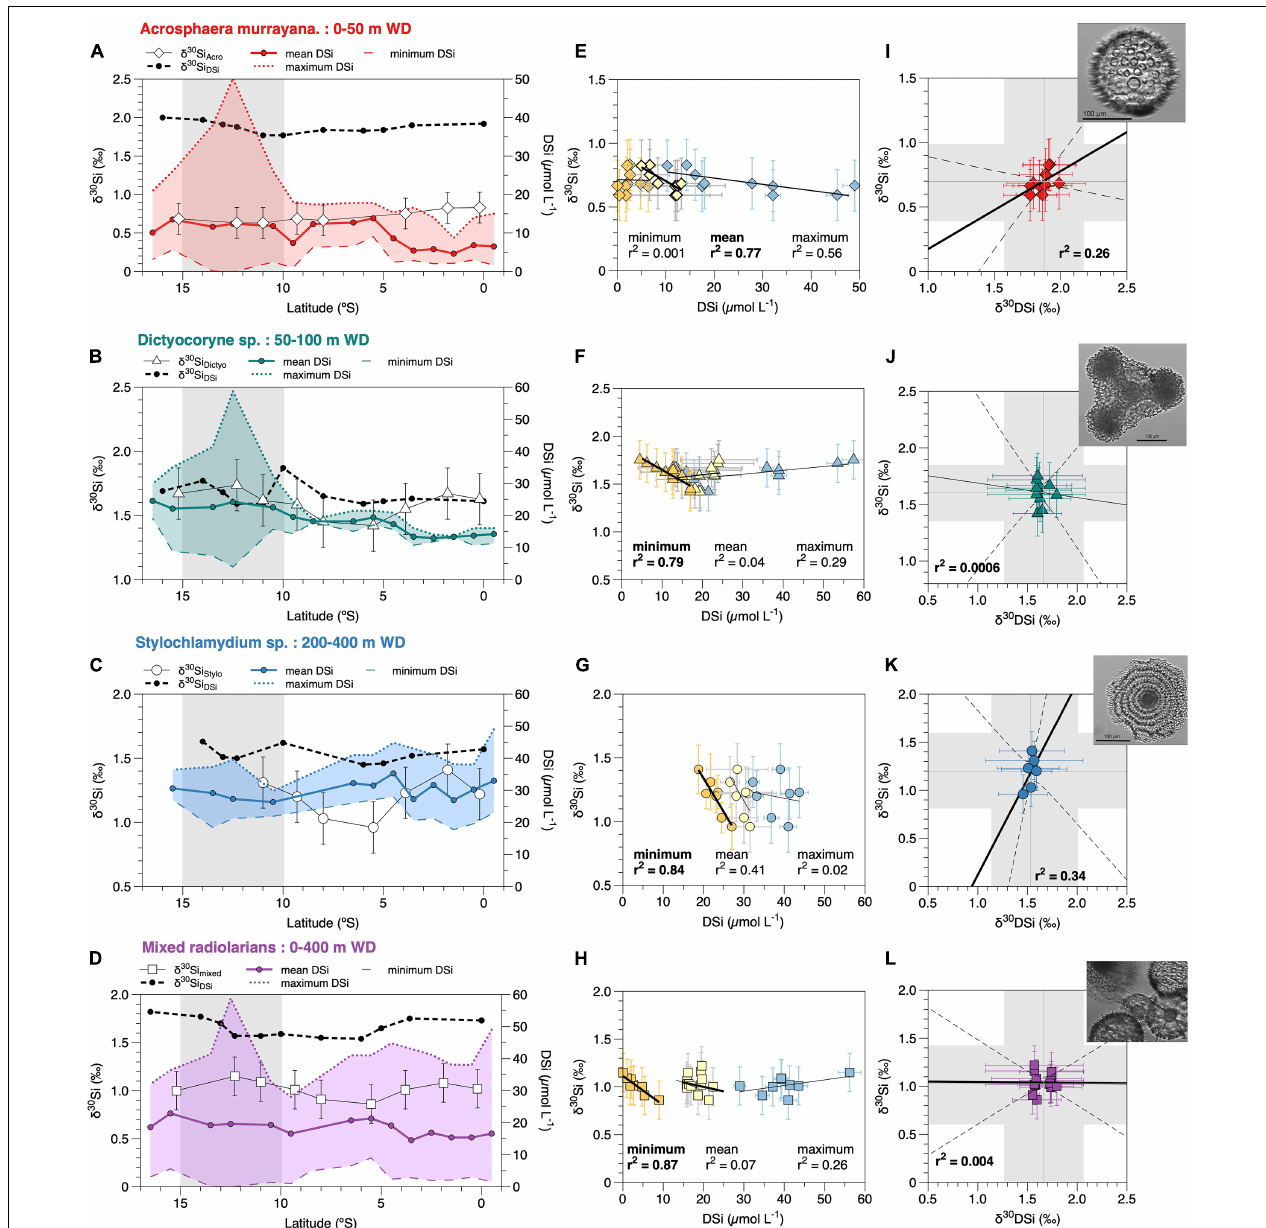
FIGURE 3 | (A–D) δ 30 Si signatures of radiolaria and the DSi concentrations of their respective habitat depth over latitude – A. murrayana (diamonds) 0–50 m, Dictyocoryne sp. (triangles) 50–100 m, Stylochlamydium sp. (dots) 200–400 m, mixed radiolaria (squares) 0–400 m water depth (WD). The DSi concentrations are given as mean (solid line), maximum (dotted line), and minimum (thin dashed line) values. The δ 30 Si DSi signatures from the respective water depths are indicated as black dashed lines. The gray shaded area indicates the main upwelling area along the coast. (E–H) Correlation of the δ 30 Si of each radiolarian group with minimum (orange), mean (yellow), and maximum (blue) DSi concentrations from their habitat depths ( Table 2 ); (I–L) Correlation of δ 30 Si DSi signatures from the respective water depth with the δ 30 Si for each radiolarian group. The gray shaded areas indicate the 2 SD error range of external reproducibility for each variable. Black solid lines indicate the linear regression, dashed lines show the confidence intervals. Pictures are representative of the respective species, as presented in Figure 1 . For better readability, all statistical values for regressions are given in Table 3 .